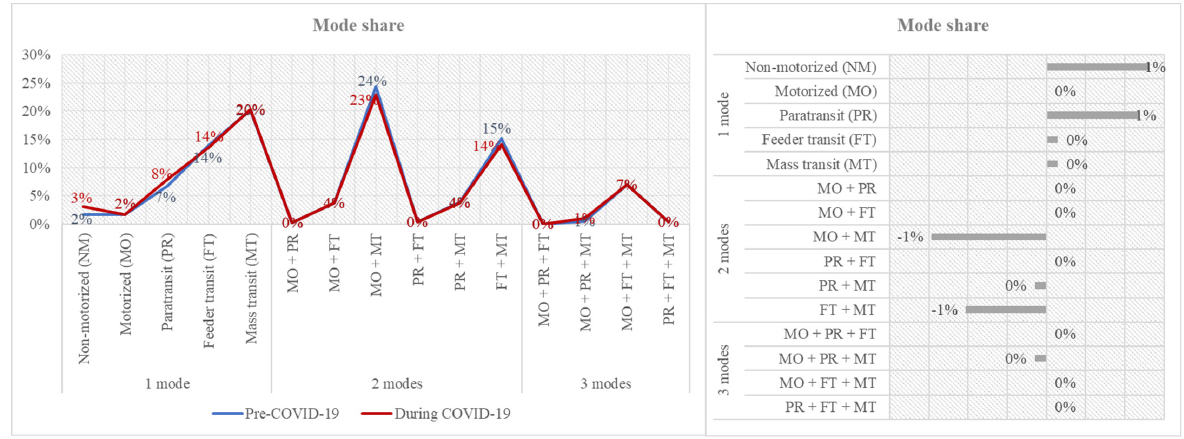
Figure 3. Comparison of mode share in pre-COVID-19 (TM1) and during COVID-19 period